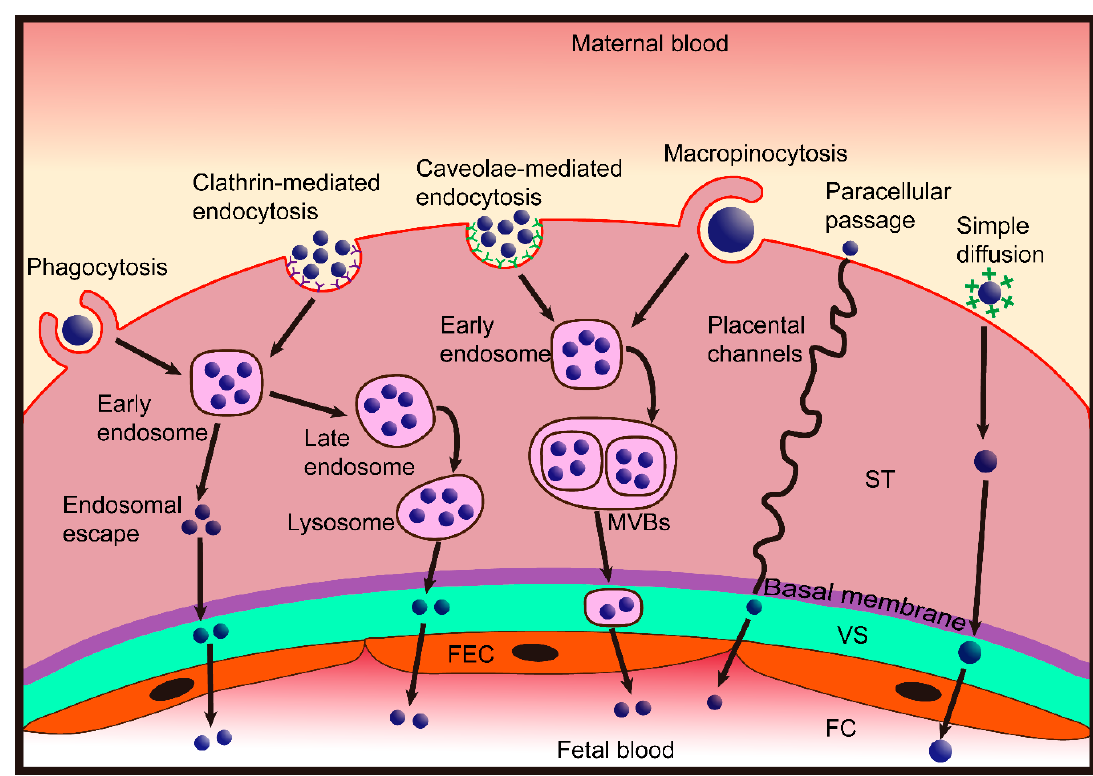
Figure 2. Scheme showing the nanoparticle transplacental transport mechanisms. Nanoparticles cross the placental barrier by paracellular passage and transcellular passage. Very small nanoparticles can penetrate syncytiotrophoblasts (ST) via placental channels and thereby enter the villous stroma (VS). Di ff usion may then occur through the fetal endothelial cells (FEC) into the lumen of the fetal capillaries (FC). The transcellular passage consists of endocytosis and exocytosis. Nanoparticles may be taken up by syncytiotrophoblasts via phagocytosis, clathrin-mediated endocytosis, caveolae-mediated endocytosis and macropinocytosis, then they may be exocytosed through the endosomal escape pathway, lysosomal secretion, and multivesicular bodies (MVBs)-related secretion. After entering the VS, nanoparticles may cross the FEC by the same pathway and eventually enter into the fetal blood. Some cationic nanoparticles may be able to directly fuse the negatively charged trophoblast cell membrane and move toward the basal membrane by simple di ff usion, thereby, di ff using through the FEC into fetal blood.